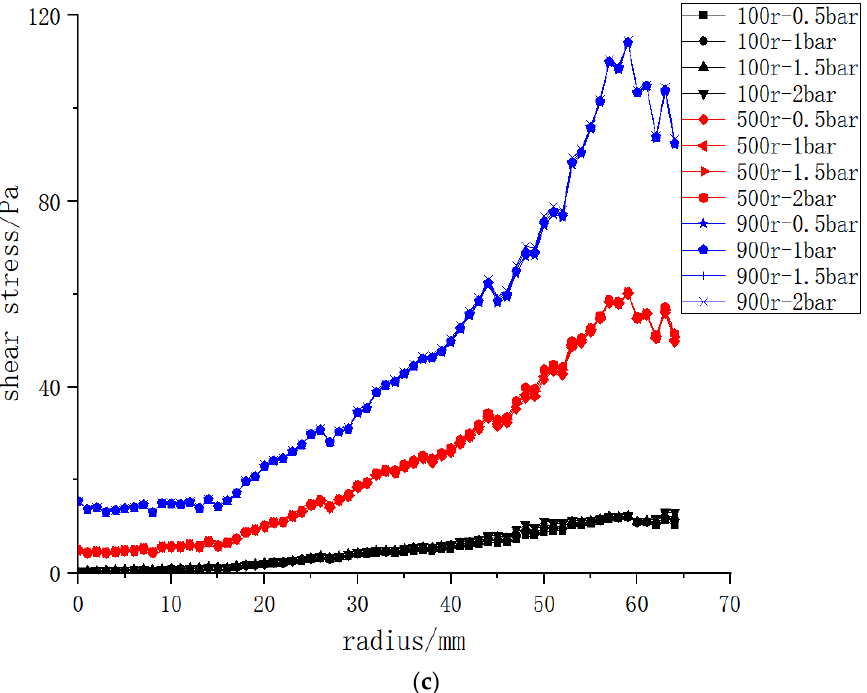
Figure 7. Cloud charts of shear force on the membrane surface of the three structures at different rotating speeds and transmembrane pressure differences: ( a ) vane ( b ) disk ( c ) propeller.